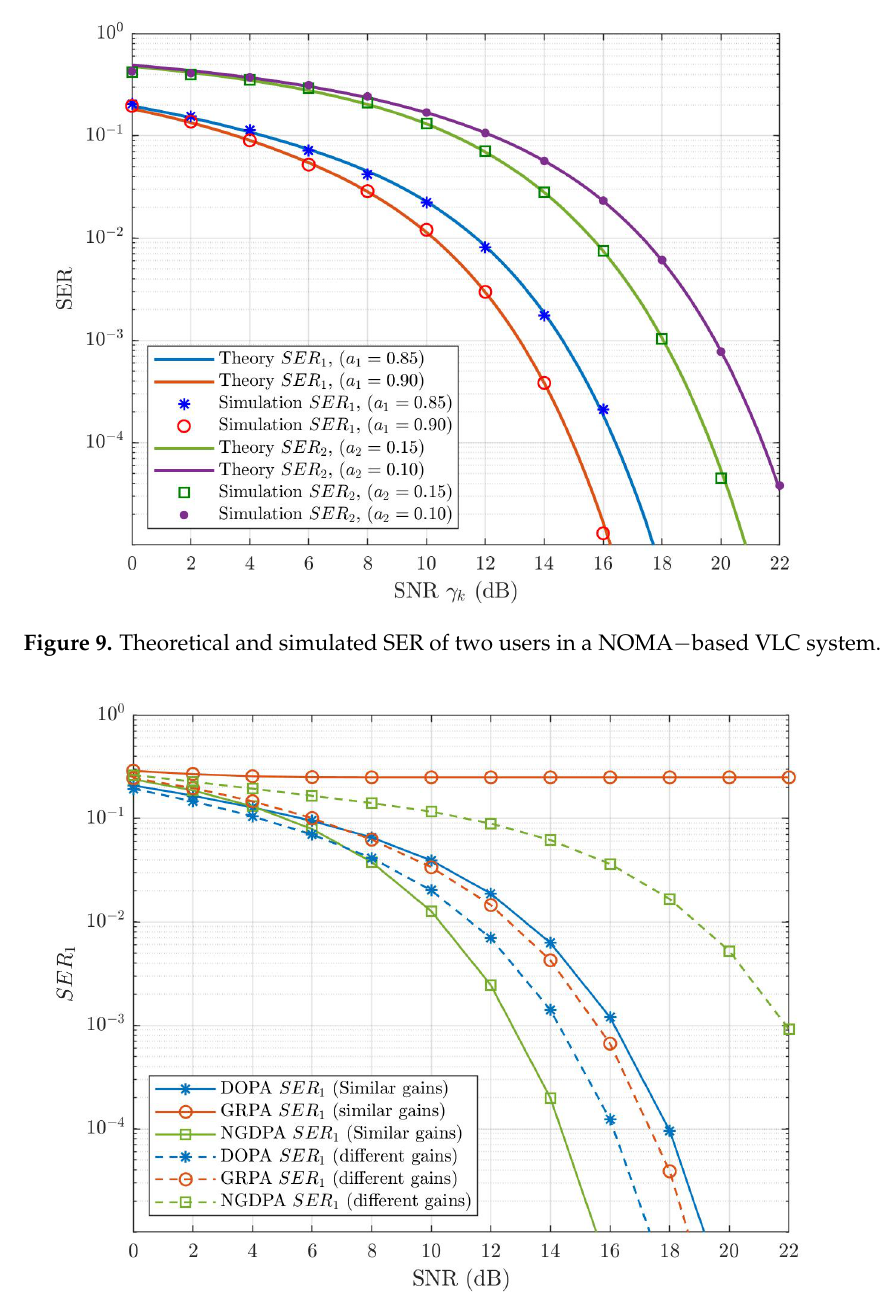
Figure 10. SER 1 using DOPA, GRPA and NGDPA. α = 2 for similar channel gains and α = 1 for different channel